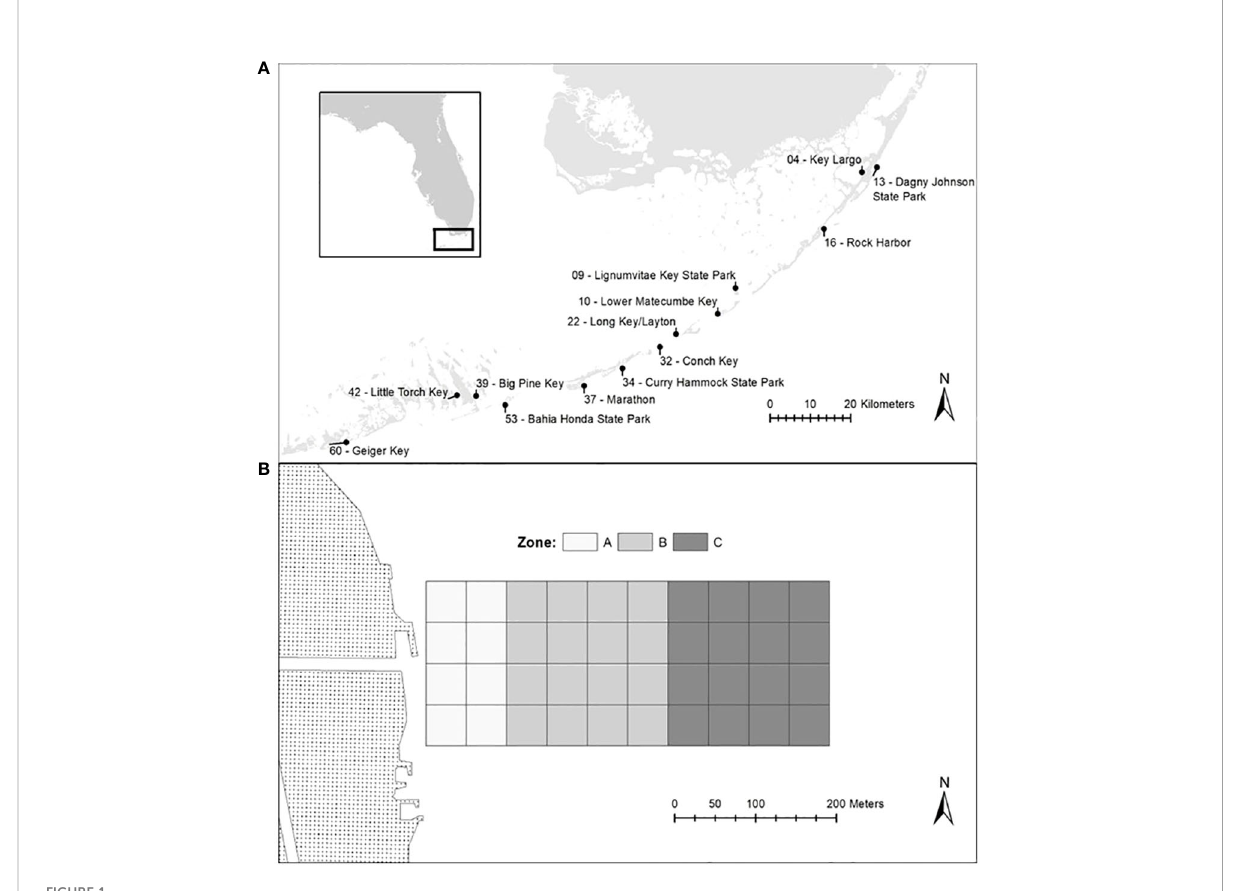
FIGURE 1 Map of the Florida Keys depicting the locations of all 13 study sites (A) and map showing the blocked experimental design (B)